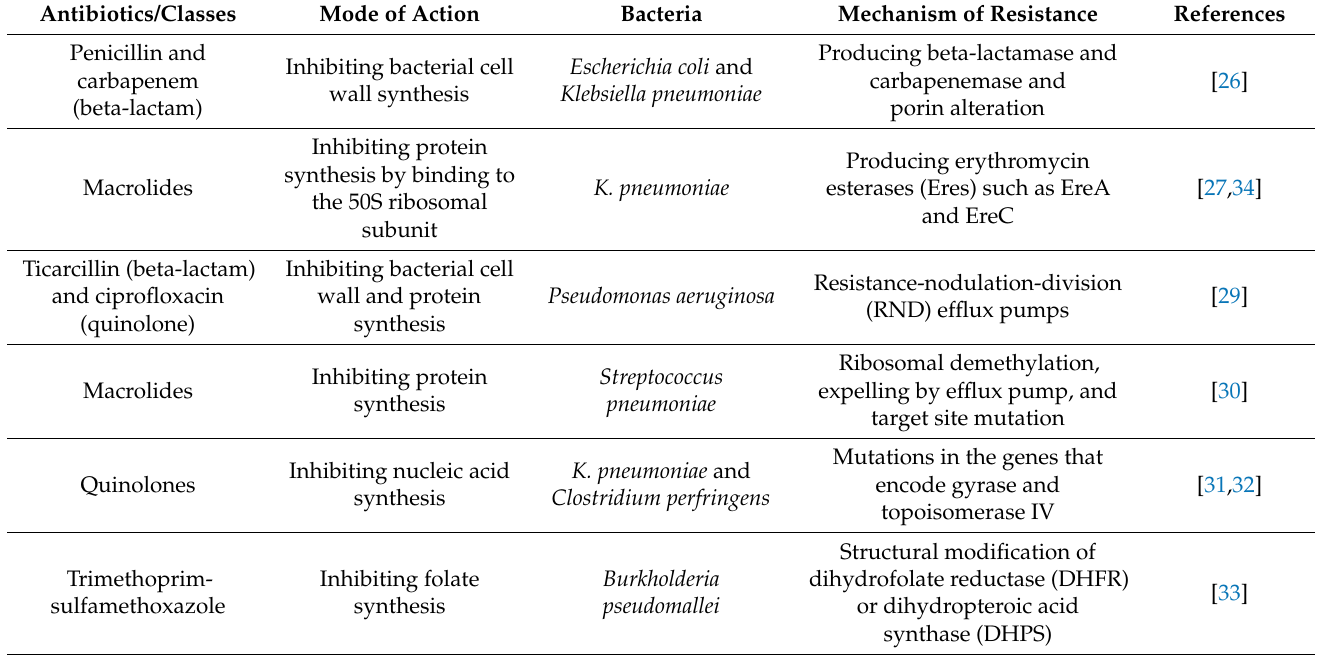
Table 1. The killing mechanisms of antibiotics and resistance mechanisms of